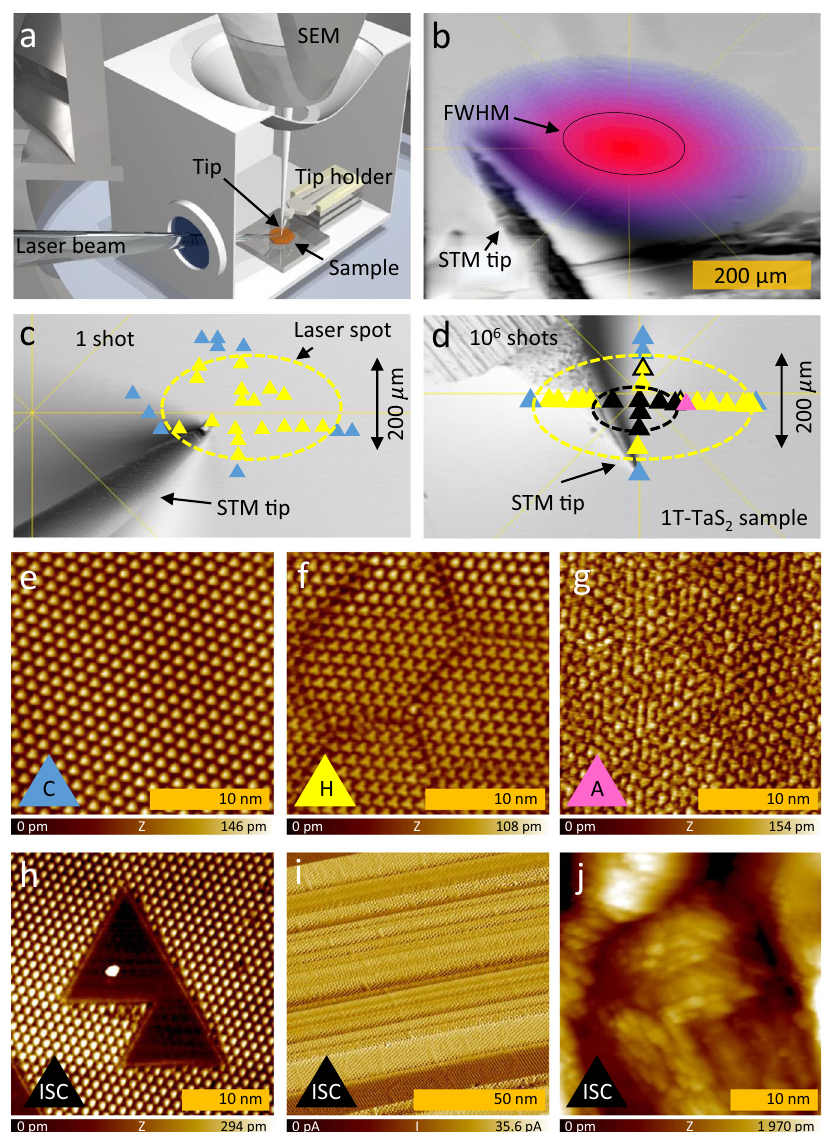
Fig. 1 The STM experiment. a A scheme of the optically excited scanning tunneling microscope (STM) setup with a vertically positioned scanning electron microscope (SEM). b SEM image of an area continuously exposed to 22 mJ/cm 2 peak fl uence, showing damage at the center of the laser spot, which was used in the initial optical setup to de fi ne the beam position. The local fl uence decreases as we move away from the center of the beam (from red to blue as marked on the image). The full width half maximum (FWHM) of the beam is marked with a black ellipse. c , d SEM images of the sample with the marked state pro fi le (colors of the triangles represent different states as de fi ned in ( e ) – ( j )) after excitation with a single shot and multiple shots respectively. The colored ellipses serve only as a guide to the eye. e – j STM images of various states achieved by photoexcitation at 5 K. e commensurate (C) state, with a perfect triangular lattice of polarons (bright spots), ( f ) hidden (H) state with domains of ordered polarons, ( g ) amorphous (A) state with hyperuniform polaronic order, ( h ), ( I ), and ( j ) different examples of irreversible structural changes (ISC), namely ( h ) polytype transformation (at 77 K), where dark regions represent the 1H polytype monolayer which has no charge modulation at this temperature 20 ( i ) 1D surface ripples and ( j ) sample present. As observed by STM for F < 7 mJ/cm 2 , such transient states with no characteristic oscillation fi ngerprint eventually evolve into either the H or the A state. Since (i) multiple pulse experiments in STM show little or no difference from single pulse experiments (with fl uences below the damage threshold) and (ii) repetitive single-shot measurements in the same spot in STM show different electronic ordering pattern of the H and A states The time-domain phase diagram with a compilation of the after each pulse, we conclude that the fi nal photoinduced states transition outcomes for different F and T is shown in Fig. 3, are recon fi gured by each pulse and independent of the initial combining STM (triangles) and transient re fl ectivity data electronic order. (squares). The time-axis signi fi es the time after the driving pulse For F > 7 mJ/cm 2 , the AM peak intensity decreases even fur- (Fig. 3a) grouping the data into three timescales: ultrashort